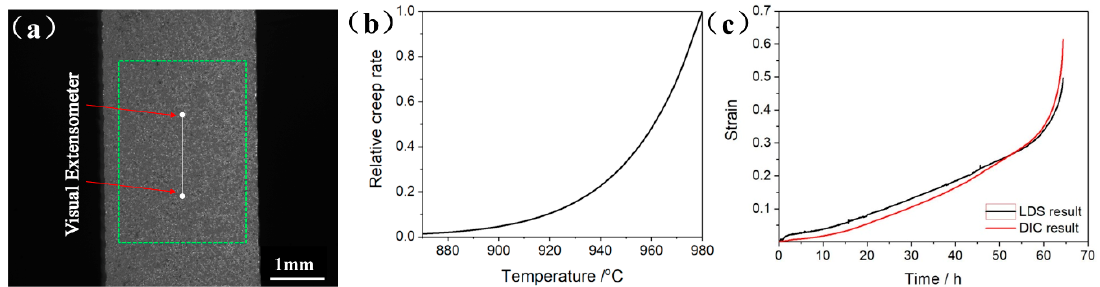
Figure 6. ( a ) The visual extensometer on TW specimens during the creep test; ( b ) the relative creep rate under different temperatures; ( c ) the LDS and DIC curves for TW creep